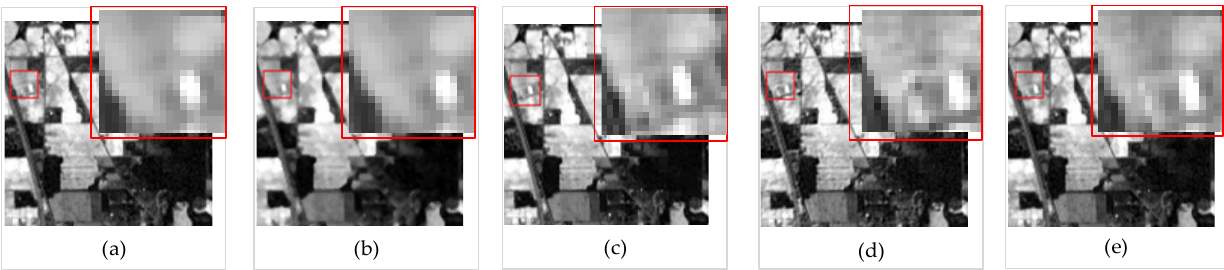
Figure 6. The denoising results of band 187 in Indian Pines. ( a ) Original image; ( b ) denoised result of KMNF-NE; ( c ) denoised result of SSDC; ( d ) denoised result of MNEM-Order; ( e ) denoised result of MNEM-Ratio.